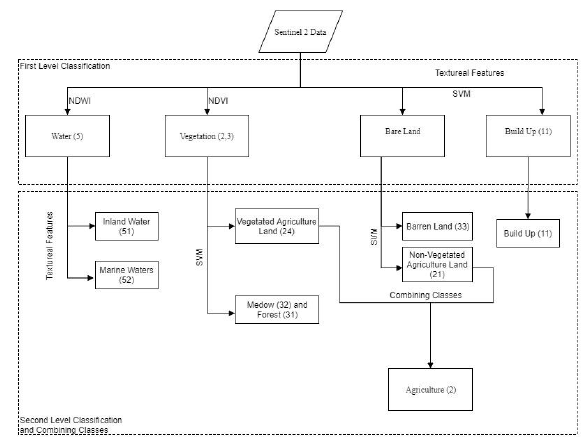
Figure 2. Flowchart of the applied classification